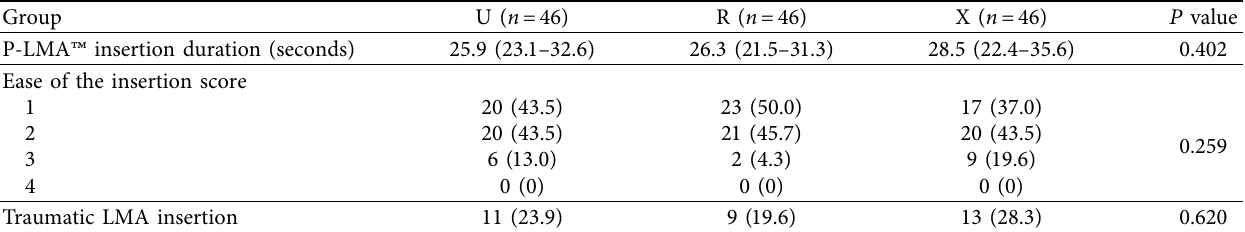
Table 4: P-LMA ™ insertion duration, ease of the insertion score, and traumatic insertion.